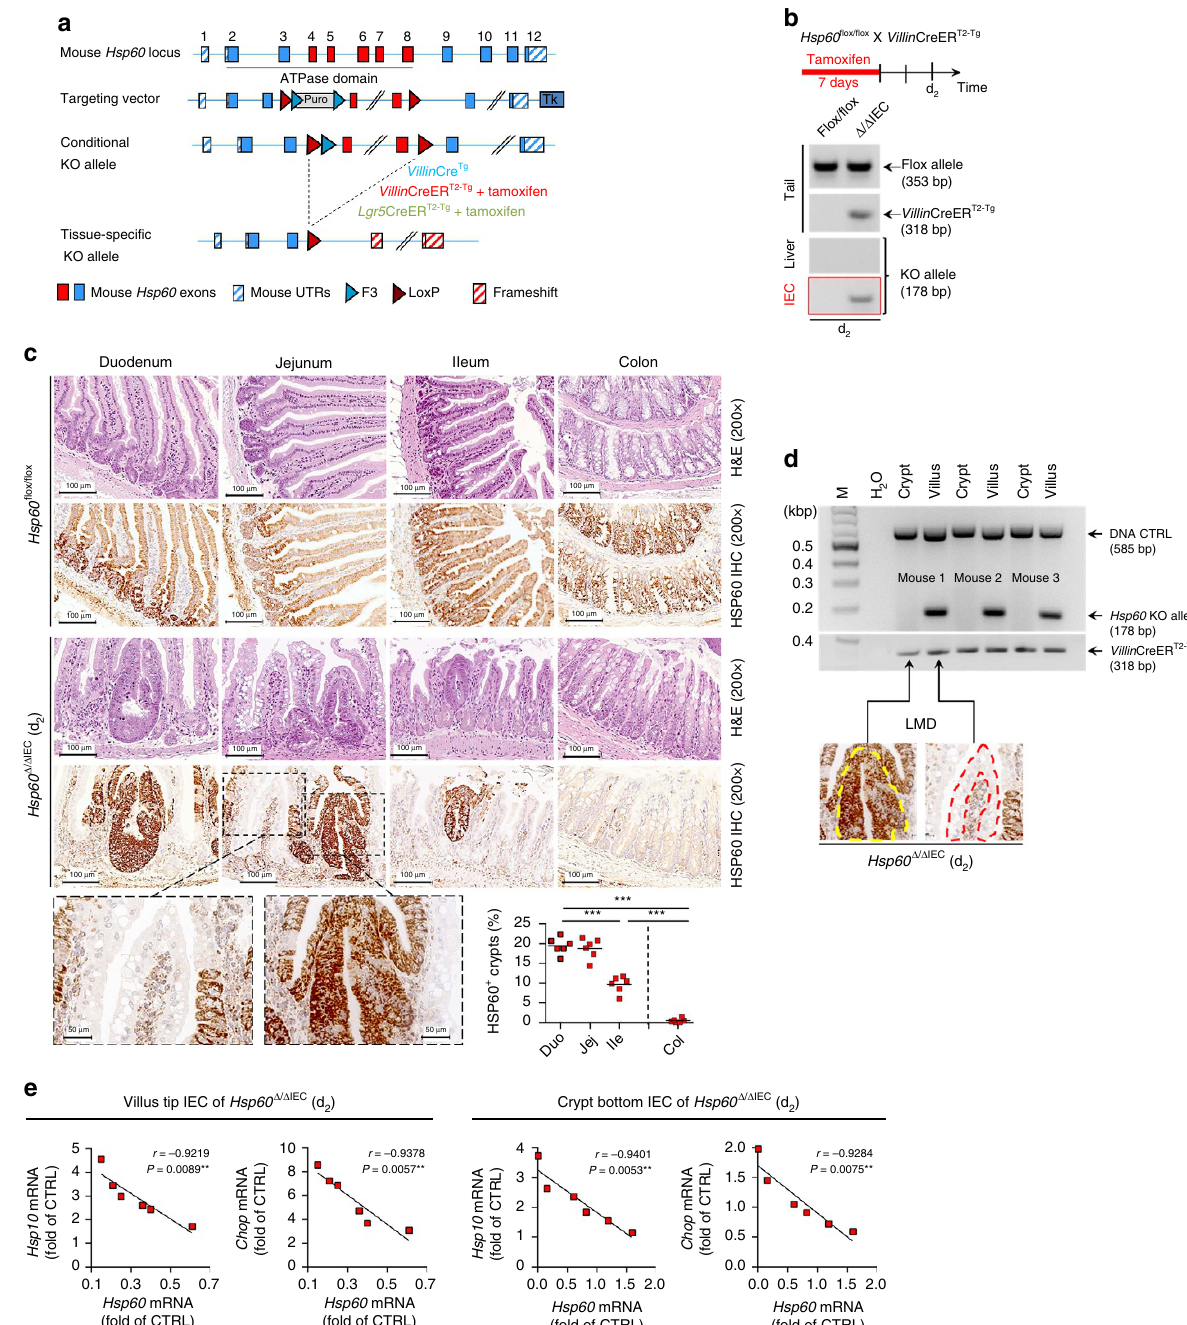
Figure 1 | Formation of hyperproliferative crypt nodules in the small intestine of Hsp60 D / D IEC mice. ( a ) Schematic illustration of the targeted genomic modifications to generate mice carrying a conditional knockout allele for Hsp60 (Flox allele). Expression of Cre recombinase and induction of Cre activity by tamoxifen generate the Hsp60 knockout specifically in intestinal epithelial cells (IEC) or intestinal stem cells (ISC). ( b ) Schedule for oral tamoxifen administration to induce HSP60 deficiency in IEC of adult mice. Agarose gels showing the presence of the knockout allele specifically in IEC isolates. ( c ) Representative H&E and corresponding HSP60 IHC stainings of Hsp60 flox/flox and Hsp60 D / D IEC mice along the intestinal tract. Images of HSP60 IHC in higher magnification show HSP60-deficient villus versus HSP60-positive crypt regions of the jejunum. HSP60-positive crypt nodules in Hsp60 D / D IEC mice were counted along the intestinal tract using HSP60 IHC stainings. The graph represents quantifications of Hsp60 D / D IEC mice ( N ¼ 6) with 4 100 crypts counted per animal. Lines indicate mean numbers. One-way analysis of variance (ANOVA) followed by Dunn’s test was used to test for significance. ( d ) Genomic DNA was isolated from villi and hyperproliferative crypt nodules of Hsp60 D / D IEC mice using laser-dissection microscopy ( N ¼ 3). Presence and absence of the Hsp60 knockout allele and Cre transgene was determined via PCR. DNA control PCR were run to check for equal loading ( e ) Correlation (Pearson) of MT-UPR marker gene expression with Hsp60 mRNA levels in IEC isolated from jejunal fractions of villus tip and crypt bottom of Hsp60 D / D IEC mice ( N ¼ 6). P values indicate one-sided significance. Asterisks indicate significant differences * P o 0.05, ** P o 0.01, *** P o 0.001; NS, not